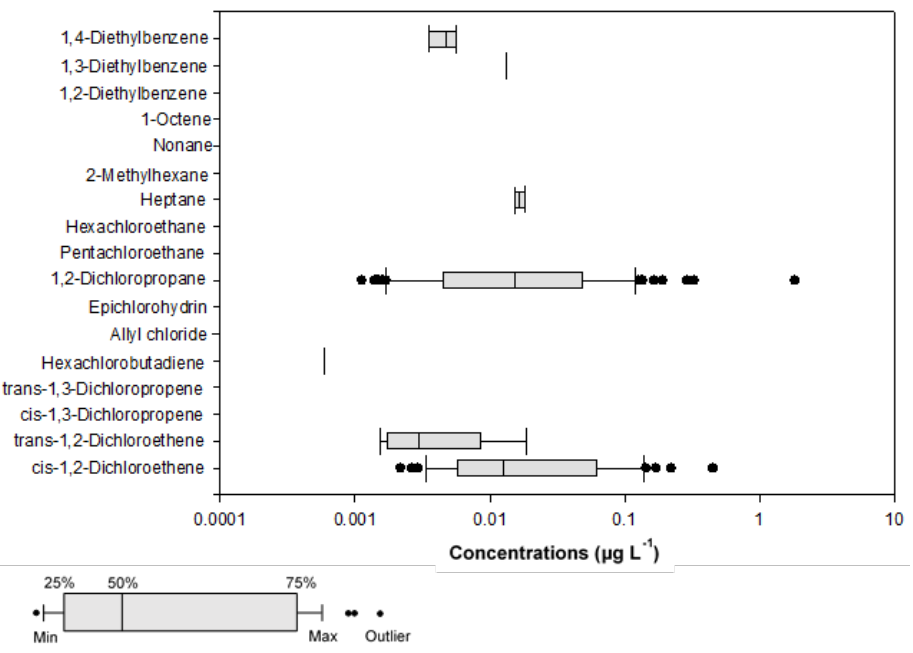
Figure 2. Box plot of volatile organic compounds (VOC) concentrations in the Han River Basin. Table 1. Measured VOC concentrations in the sampling